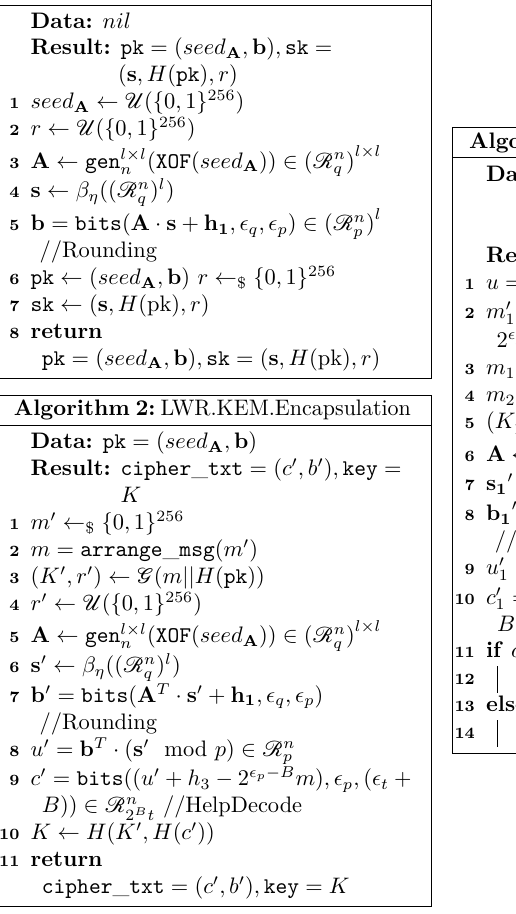
Algorithm 1: LWR.KEM.KeyGeneration